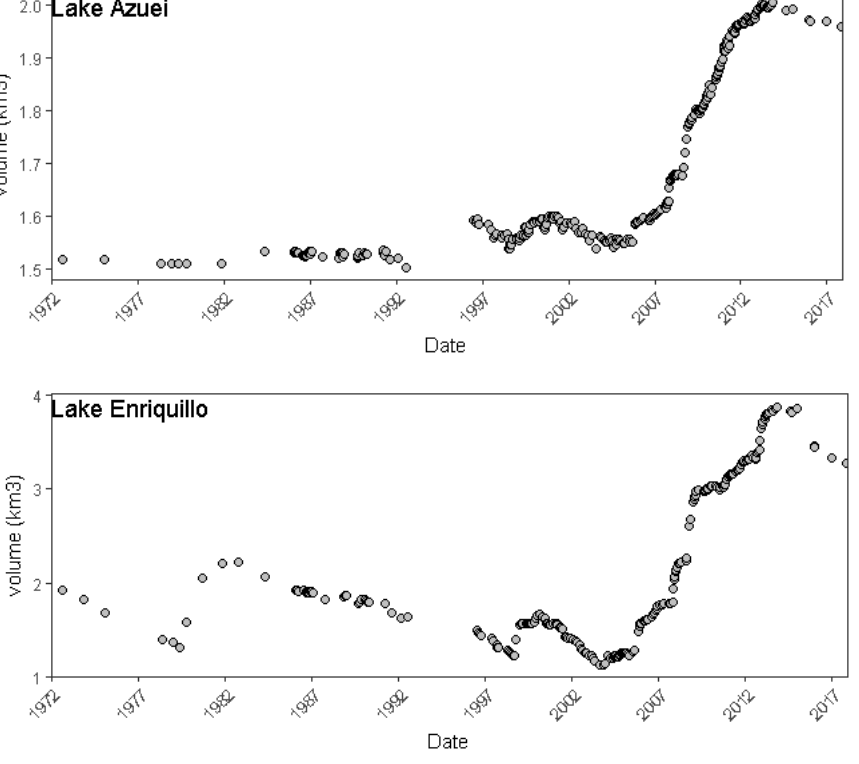
Figure 2. Lakes Azuei’s and Enriquillo’s volume time series.